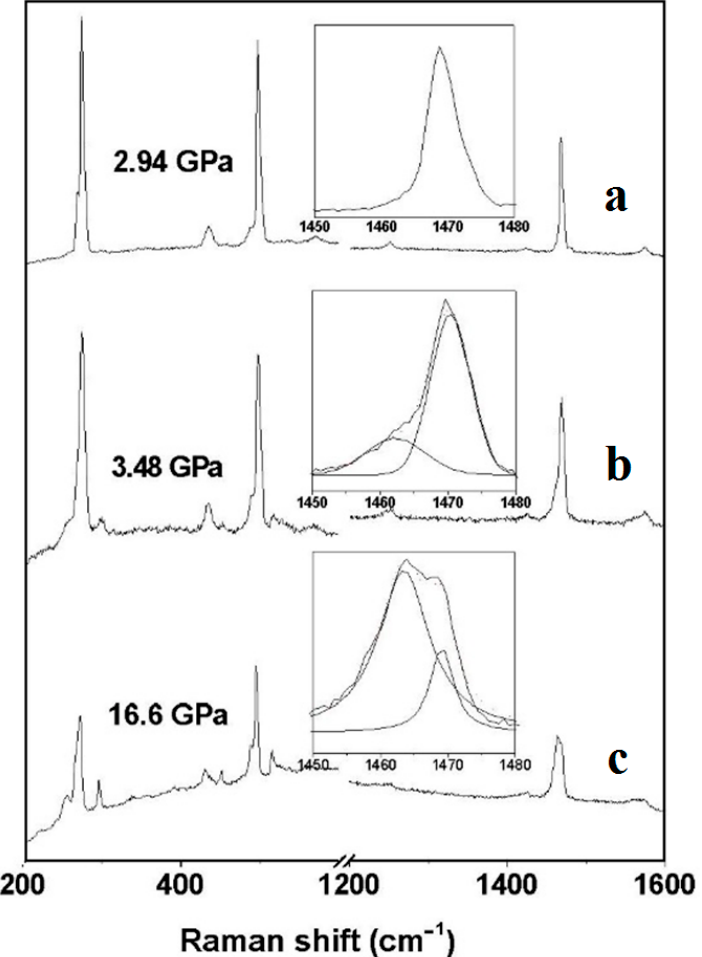
Figure 4. The Raman spectra of the samples recovered from different pressures of 2.94 GPa ( a ), 3.48 GPa ( b ), and 16.6 GPa ( c ).